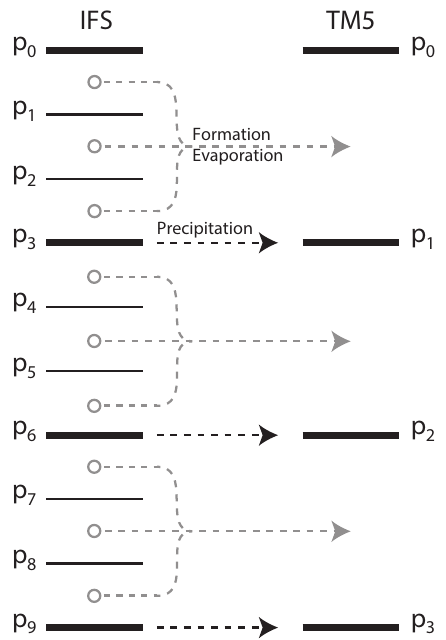
Figure 1. Regridding of additional meteorological fields in the cou- pling process between IFS and TM5. The mass flux of falling pre- cipitation is directly sampled at the pressure levels shared by both modules. For precipitation formation and evaporation, a volume- weighted average is calculated for multiple IFS pressure levels cor- responding to one TM5 pressure